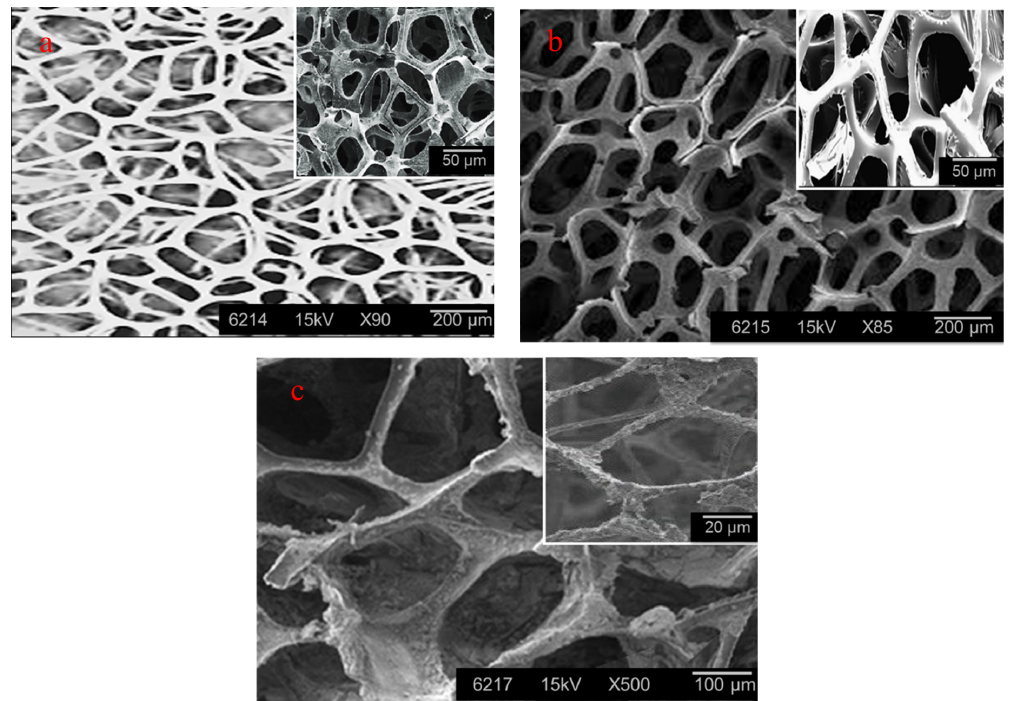
Figure 3. SEM images of ( a ) white PUF (Inset: SEM morphology of white PUF at 50 μm); ( b ) PUFS (Inset: SEM morphology of PUFS at 50 μm), and ( c ) PUFS–CPF (Inset: SEM morphology of PUFS–CPF at 20 μm).